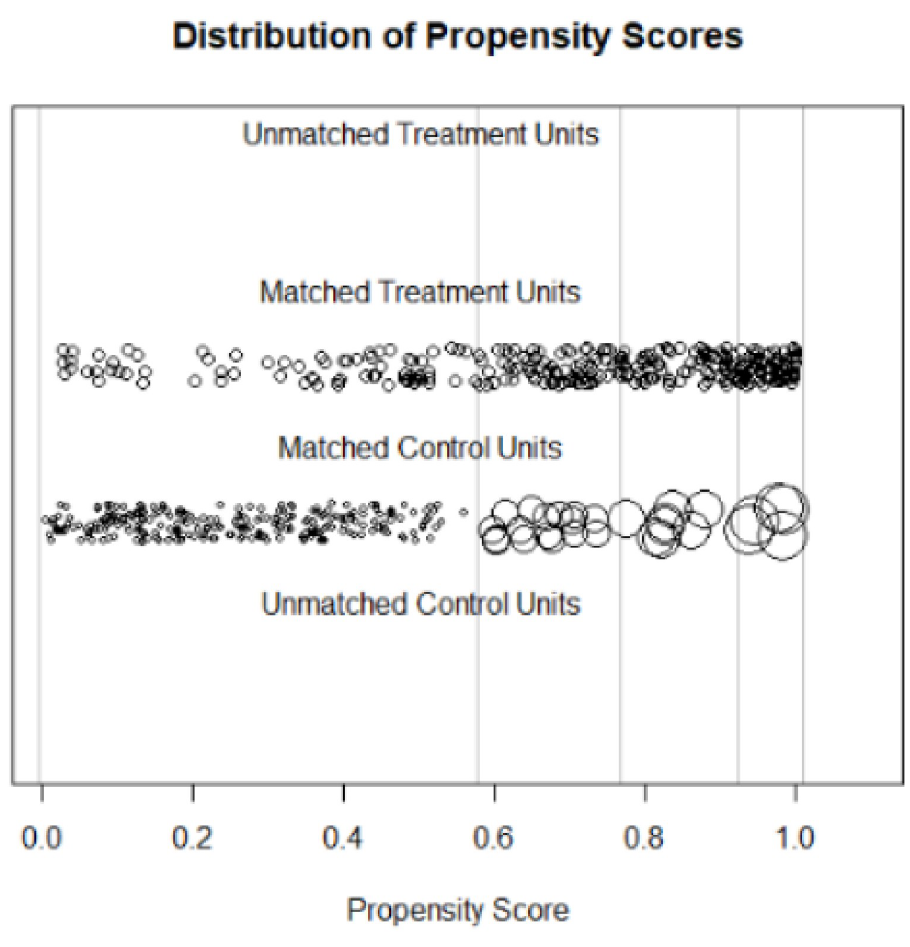
Fig 2. Distribution of propensity scores.